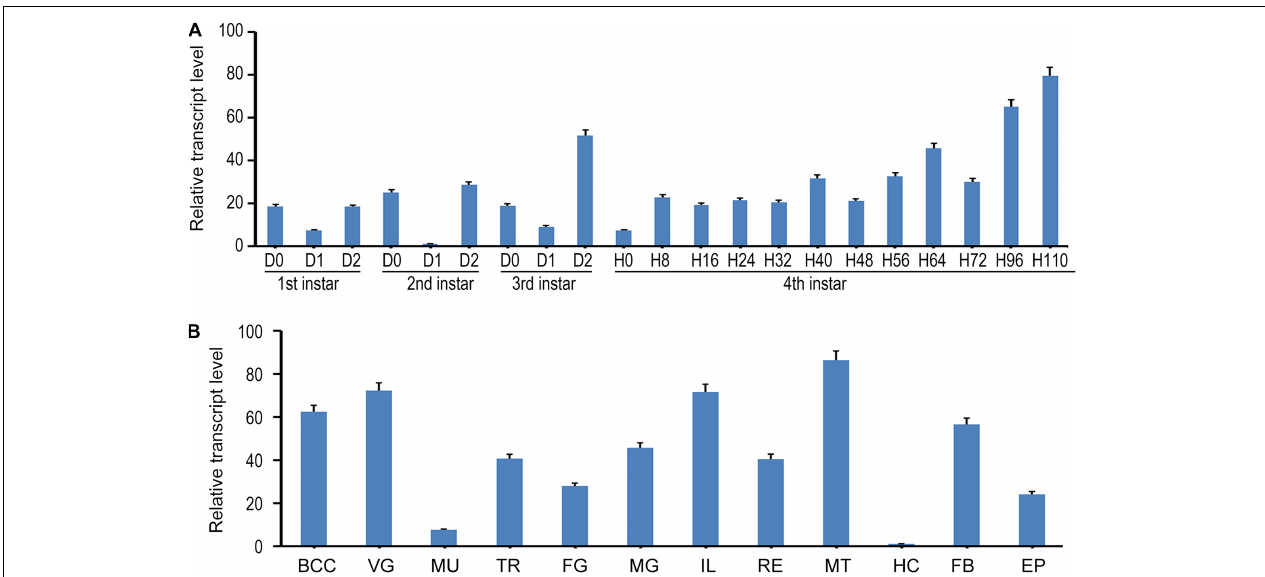
FIGURE 2 | The expression pattern of LdTai in L. decemlineata . (A) Temporal expression analysis. The cDNA templates were derived from the first, second, and third larval instars at the interval of 1 day, and from fourth larval instars at the interval of 8 or 12 h (IxD0/IxH0 indicated newly ecdysed larvae). (B) Tissue expression analysis, the cDNA templates are from total RNA extracted from the brain-corpora cardiaca-corpora allata complex (BCC), ventral ganglion (VG), muscle (MU), trachea (TR), foregut (FG), midgut (MG), ileum (IL), rectum (RE), Malpighian tubules (MT), hemolymph (HE), fat body (FB), and epidermis (EP) of the day 4 fourth-instar larvae. For each sample, 3 independent pools of 5–10 individuals are measured in technical triplicate using qRT-PCR. The bars represent 2 − (cid:49)(cid:49) Ct value ( ± SE) normalized to the geometrical mean of house-keeping gene expression. The relative transcript levels are the ratios of relative copy numbers in different developing stages to larvae at day 1 second-instar stage, or the ratios of relative copy numbers in different tissues to hemocytes